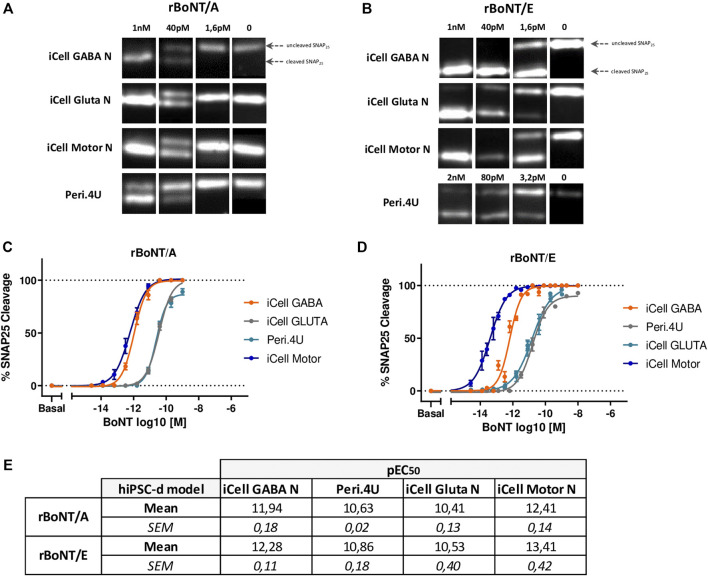
Sensitivity of the 4 models to rBoNT/A and rBoNT/E. (A,B): Western Blots showing the cleavage of SNAP25 in the 4 different cellular models after treatment of BoNT/A (A) or BoNT/E (B) at different doses. (C,D) Dose response curves of SNAP25 cleavage for BoNT/A (C) and BoNT/E (D). (E) Table of the potencies (pEC50) for BoNT/A and BoNT/E in each model; n = 3 for all models.